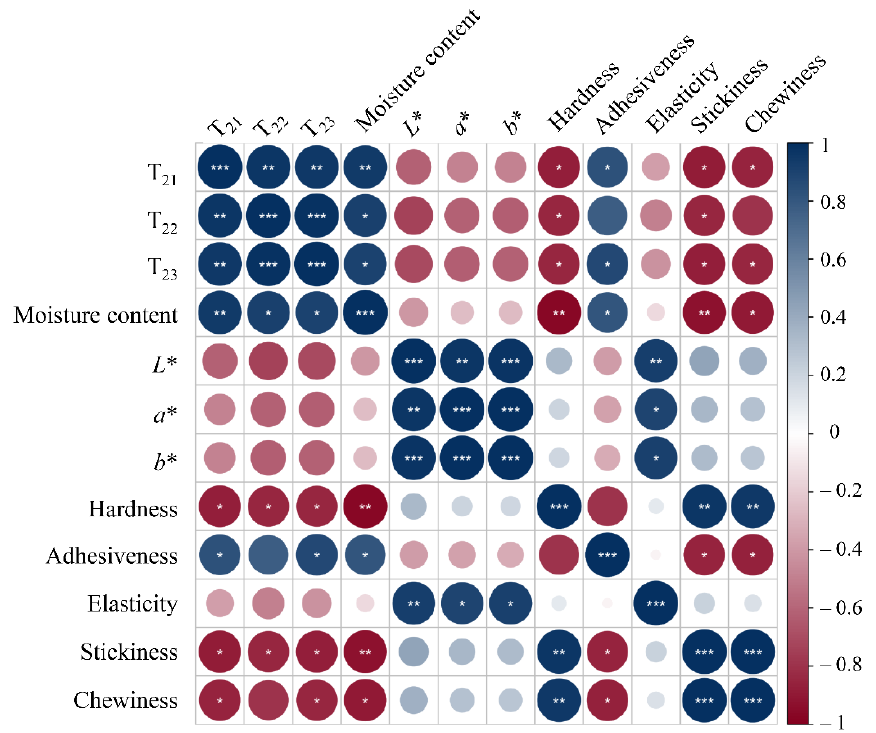
Figure 5. Correlation analysis between LF-NMR relaxation parameters and moisture content, color, texture of shrimp during drying.